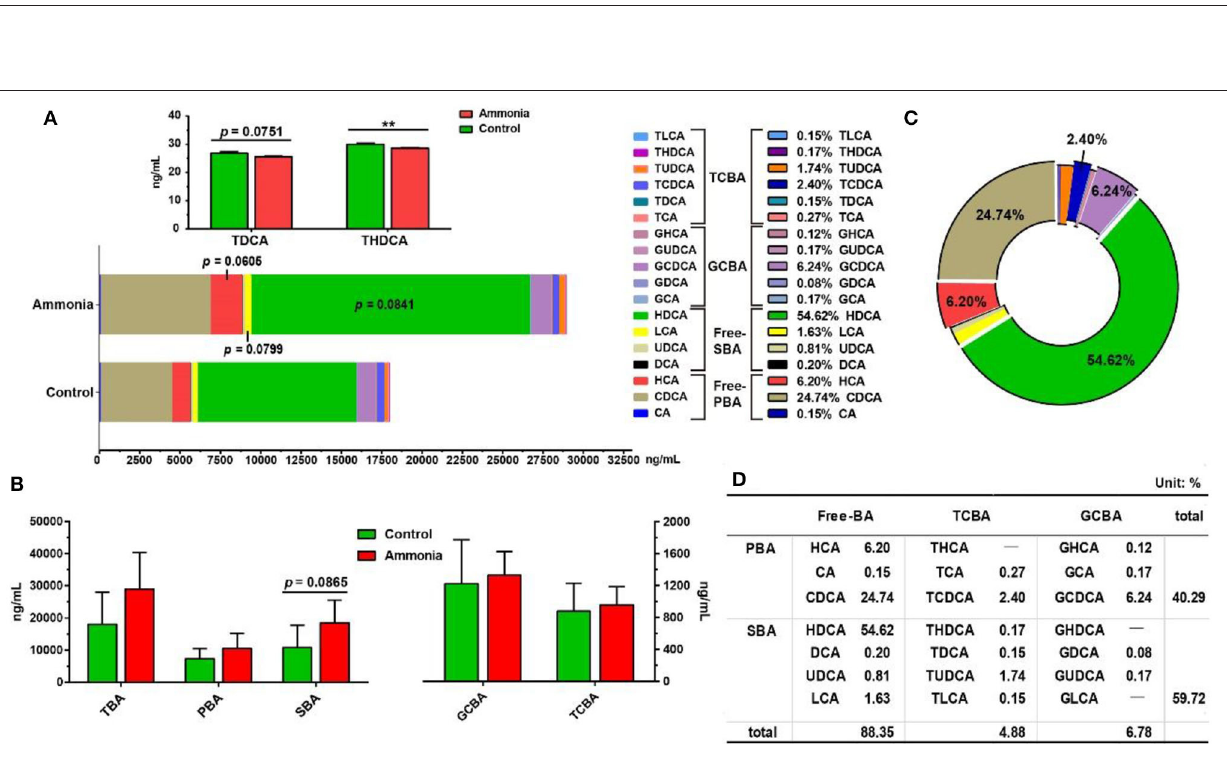
FIGURE 2 | The alteration in serum BA profiles caused by ammonia exposure. The changes in (A) each BA content and (B) each type of BA content in the serum of pigs exposed to high ammonia; (C) the compositions of each BA and (D) each type of BA in the serum of control pigs. Data are expressed as mean value or mean ± SE ( n = 6), ** p <